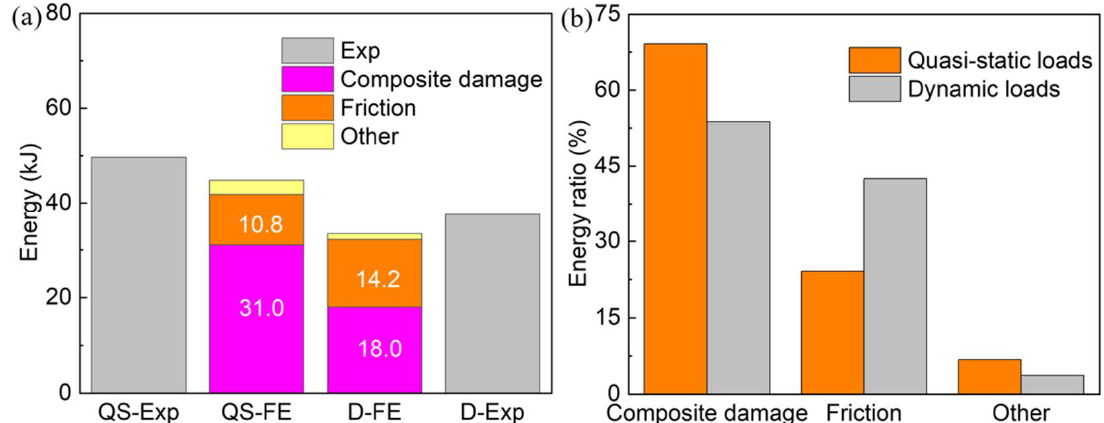
Figure 15. Comparisons of ( a ) energy components and ( b ) their proportion to total energy absorption of composite tubes subjected to quasi-static (QS) and dynamic (D) loads.